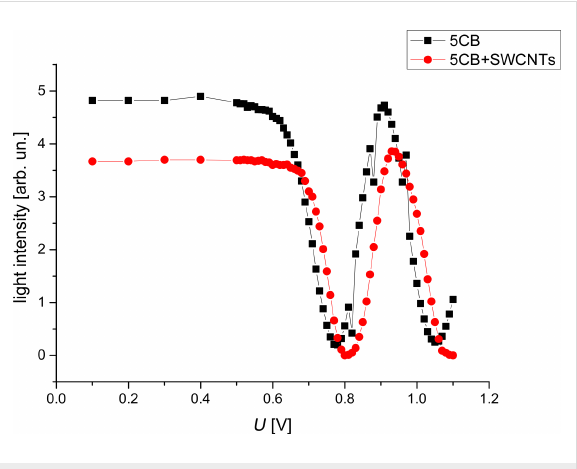
Figure 6: Fréedericksz transitions for 5CB and 5CB +